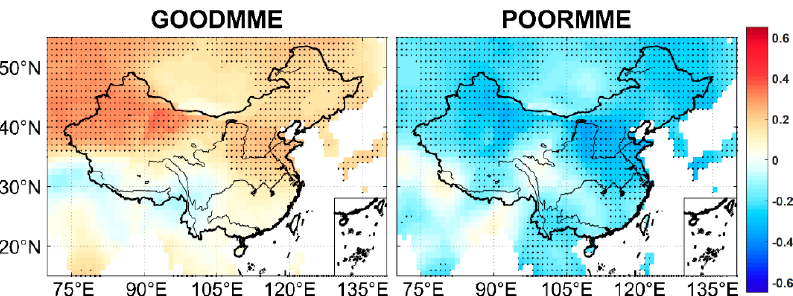
Figure 6. Spatial correlation map of the PDO and CWT (same as in Figure 4). ( a ) GOODMME and ( b ) POORMME.